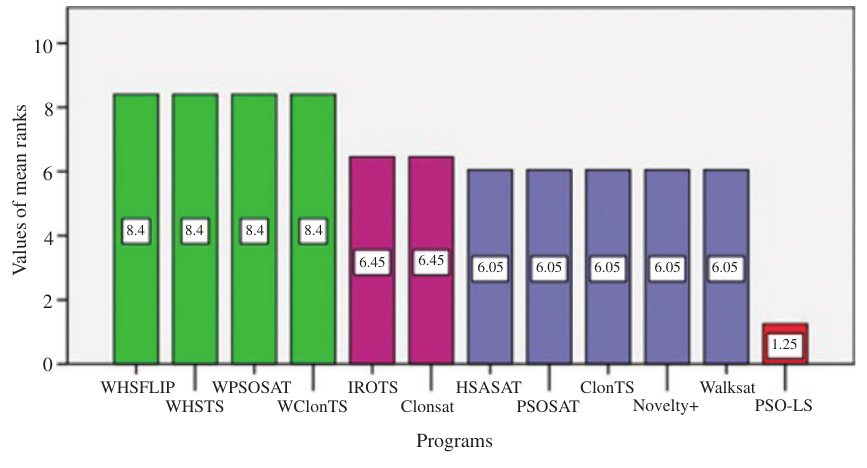
Figure 3: Friedman Test for Satisfiable